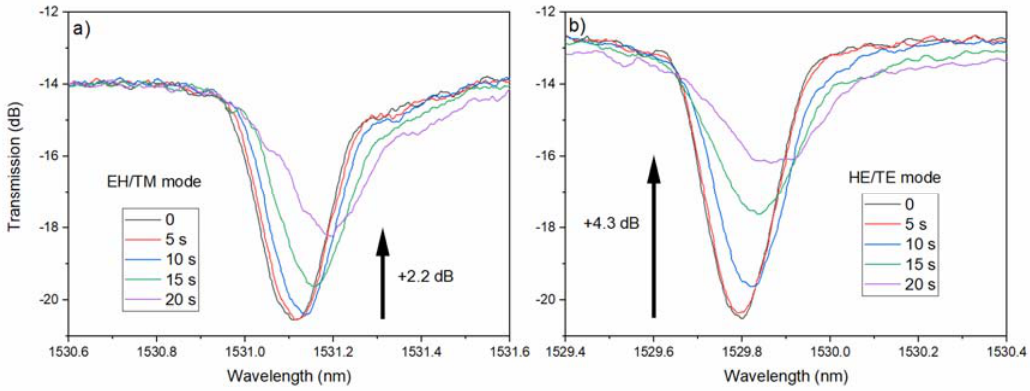
Figure 6. Evolution of ( a ) P-polarized and ( b ) S-polarized cladding mode resonances at various times (indicated in the legend) during the deposition of a 50 nm thick gold coating by CVD.